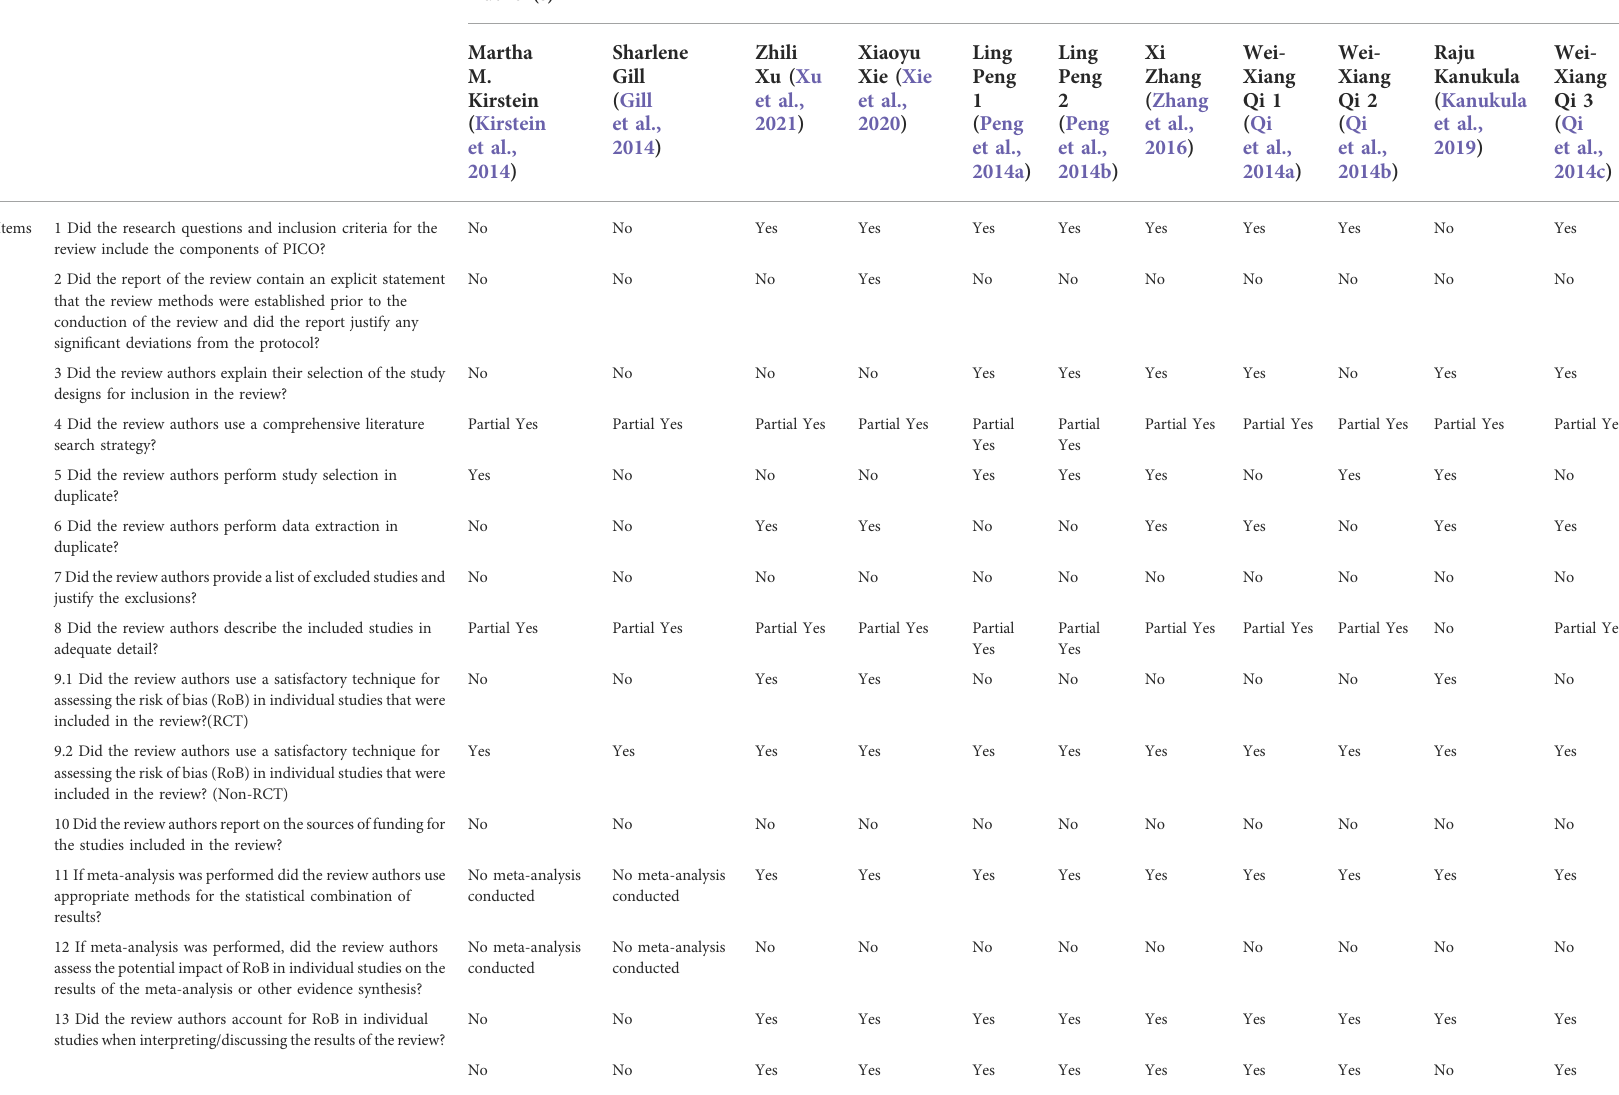
TABLE 6 Quality evaluation of included